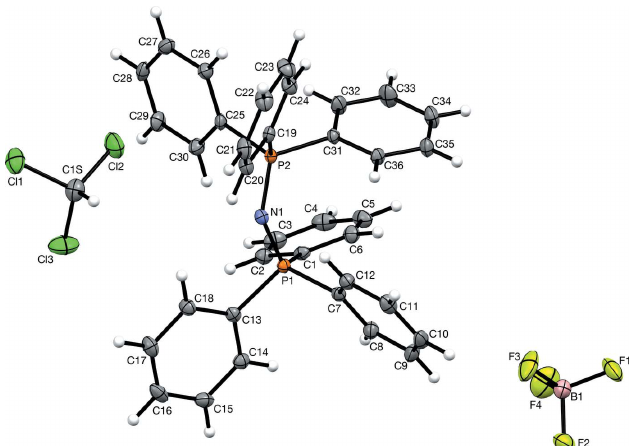
Figure 1 A view of the asymmetric unit of [PPN]BF 4 (cid:2) CHCl 3 with displacement ellipsoids drawn at the 50% probability level. For clarity only the major disorder components of the BF 4 (cid:3) anion and CHCl 3 solvent molecule are